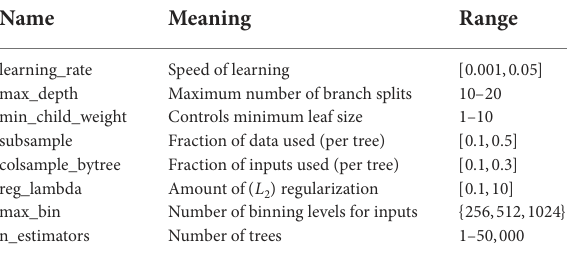
TABLE 1 List of hyperparameters investigated, with a brief explanation of their meaning and range of their